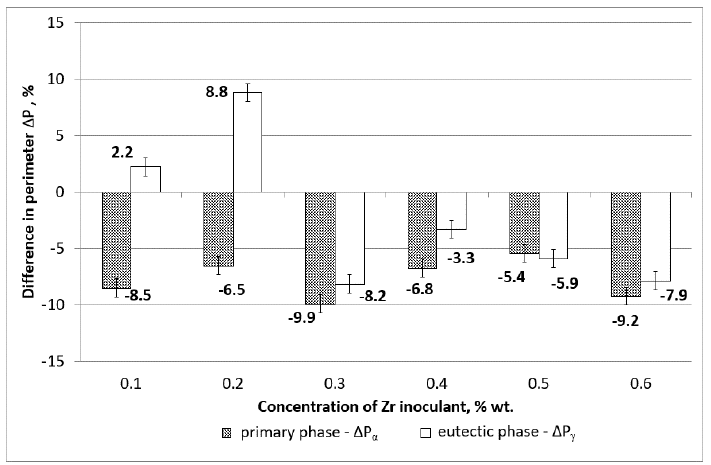
Figure 5. Change of the grain perimeters of phase α Mg and α Mg + γ (Mg 17 Al 12 ) in samples inoculated in reference to AZ91.